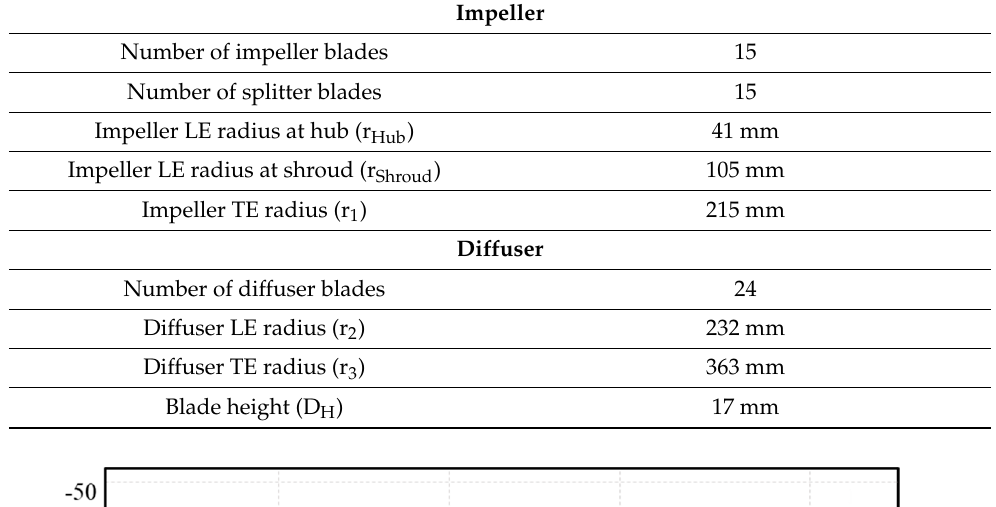
Table 1. Specification of the geometrical parameters.